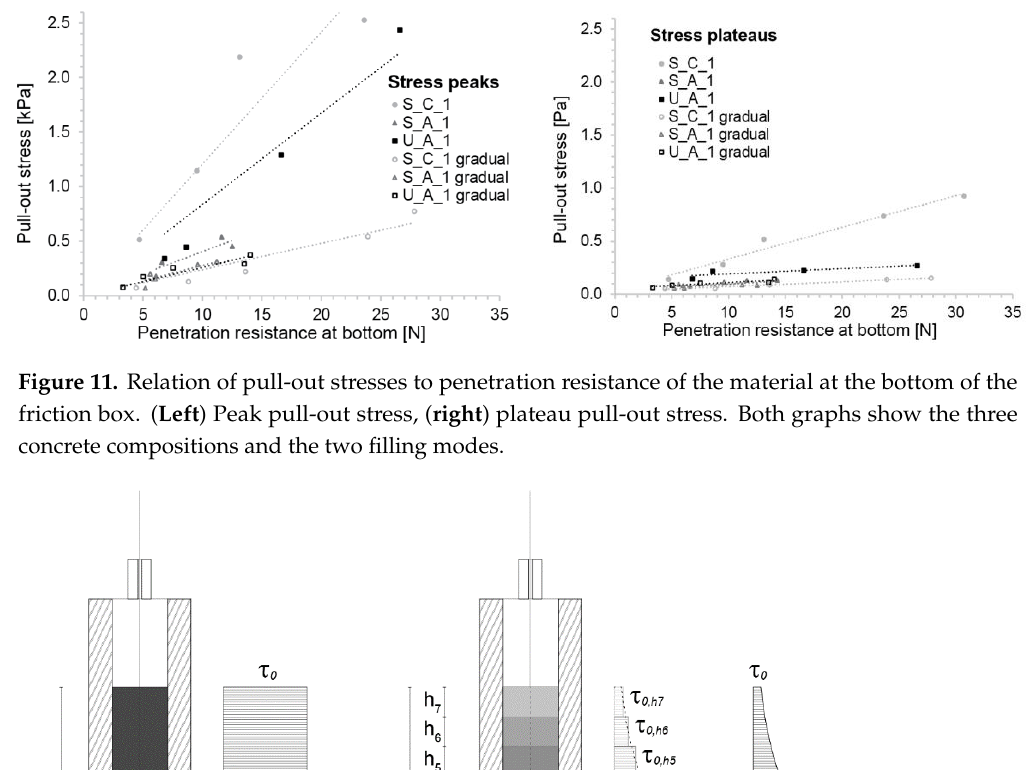
Figure 12. Yield stress of the concrete filled into the container at once (left) and gradually (right).